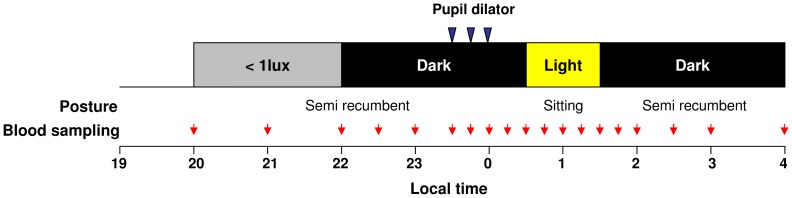
Melatonin suppression protocol.Experimental sessions started at 20:00 h and lasted until 04:00 h. Subjects were in dim light (<1 lux) between 20:00 h and 22:00 h and in total darkness afterwards. Pupils were fully dilated using antimuscarinic eye drops with one drop at three recurrences (−60, −45 and −30 minutes) prior light exposure. Subjects were exposed to 60 minutes (00:30 h–01:30 h) of monochromatic light at 9 different wavelengths (420–620 nm) of equal photon density (3.16×1013 photons/cm2/sec) over 9 experimental sessions. Outside light stimulation segment during which they were in a sitting position (90°) participants were in a semi recumbent position (45°). Blood samples were collected every 15–60 minutes and plasma melatonin was assayed by RIA. Control-adjusted melatonin suppression was compared across light treatments and sensitivity spectra were established for each subject.